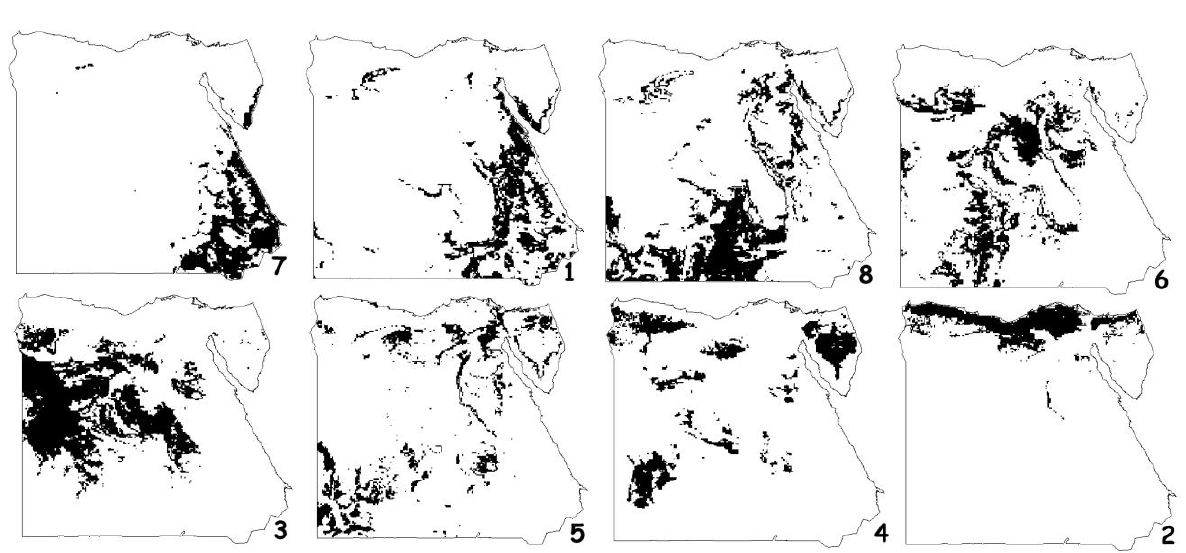
Figure 4. Spatial distribution of the eight cluster centroids.